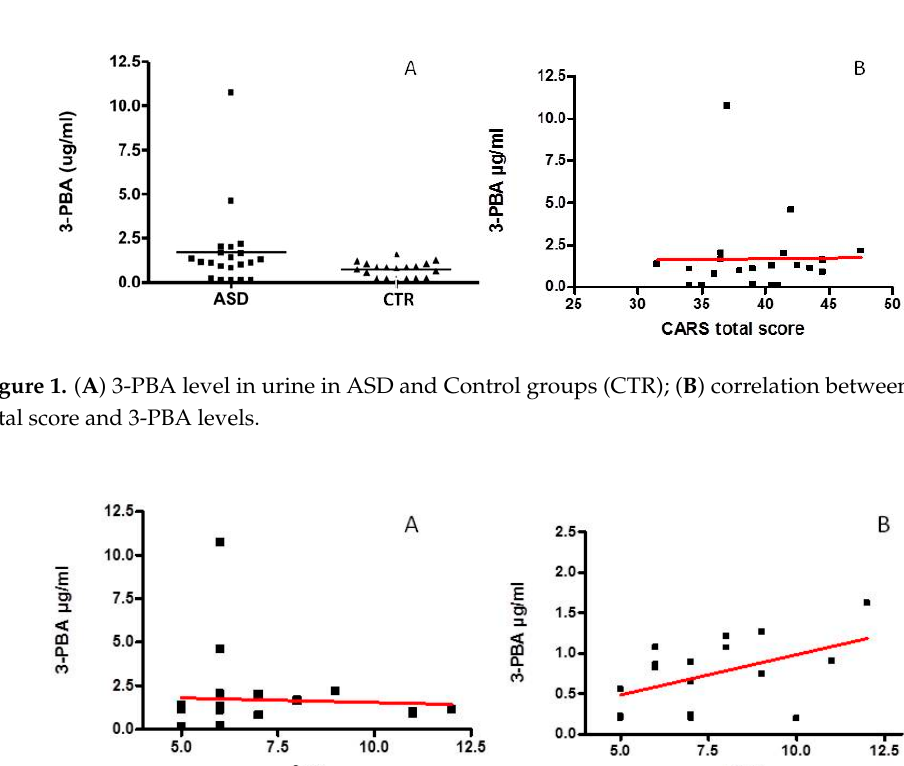
Table 1. Metals and macro/microelements in hair of ASD and CTR